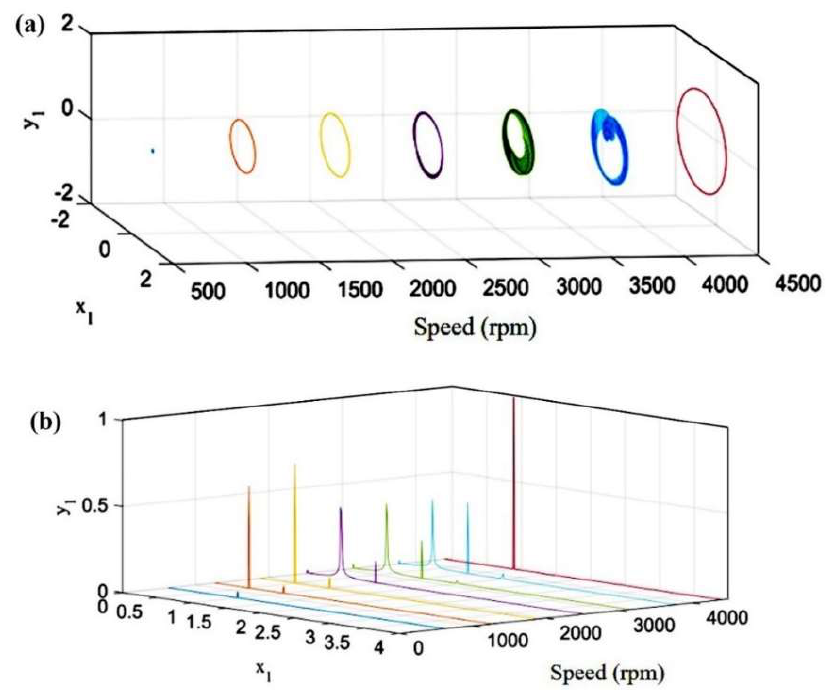
Figure 6. ( a ) Rotor axis trajectory at different speeds and ( b ) rotor spectrum at different speeds.